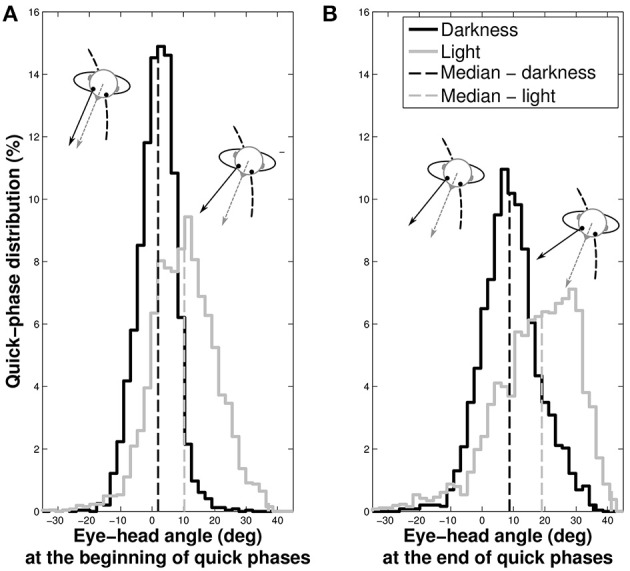
Distributions of the eye position with respect to the head at the beginning (A) and at the end (B) of quick phases. The gray spectrum represent data taken in light and the black spectrum the data in darkness. The dashed vertical lines indicate the median of the distributions.